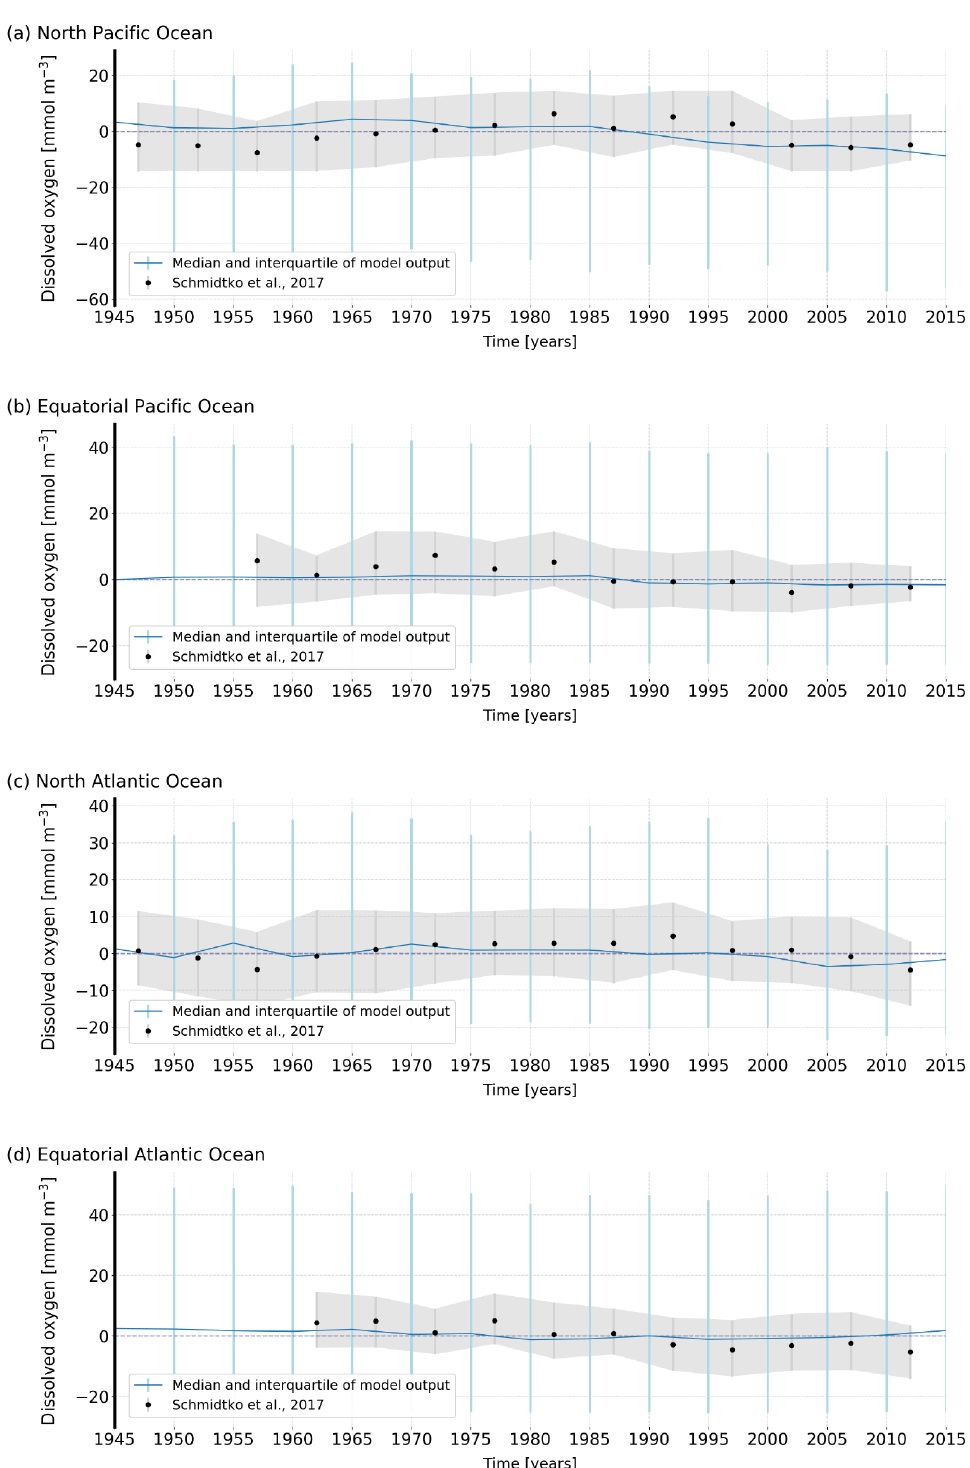
Figure A3. Comparison of the semi-decadal median and interquartile range of the simulated O 2 concentration (blue) and the historical data from Schmidtko et al. (2017) (grey) over the (a) North Pacific, (b) equatorial Pacific, (c) North Atlantic and (d) equatorial